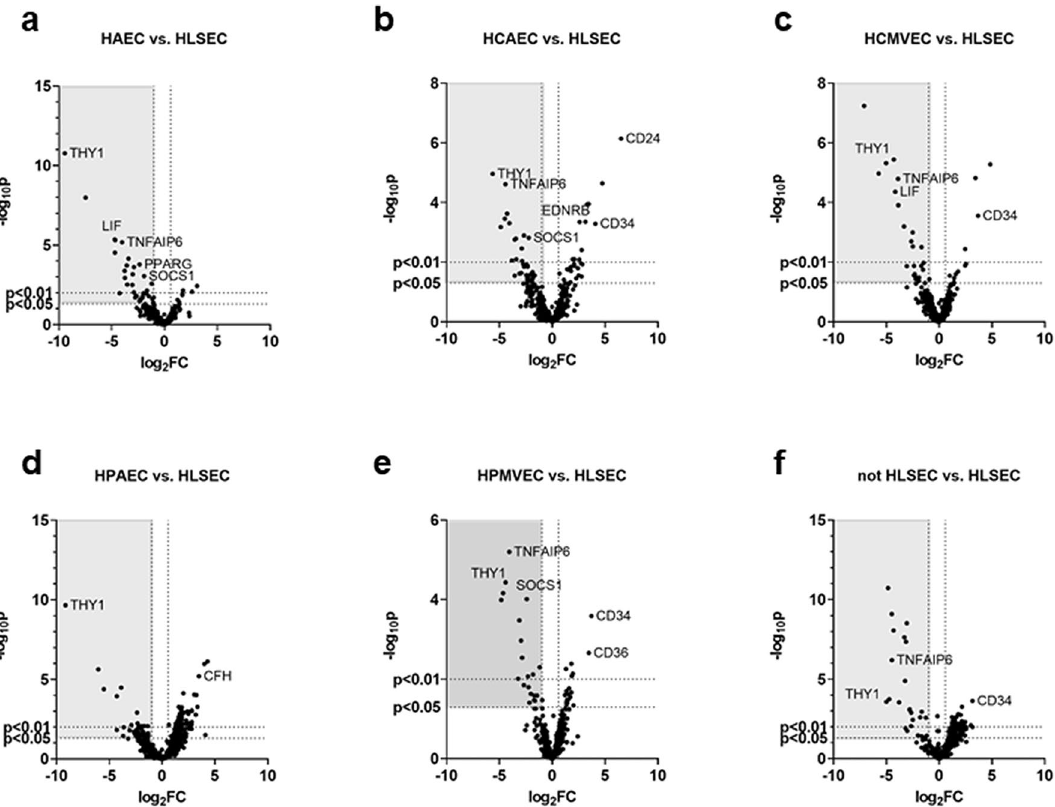
Figure 6. Differential immune gene expression across unstimulated endothelial cells. Volcano plots compare gene expression within each cell type to HLSEC ( a – e ) and compare HLSEC to all other non-liver endothelium as a group ( f ). (HAEC, n = 8; HCAEC, n = 4; HCMVEC, n = 7; HPAEC, n = 6; HPMVEC, n = 7; HLSEC, n =